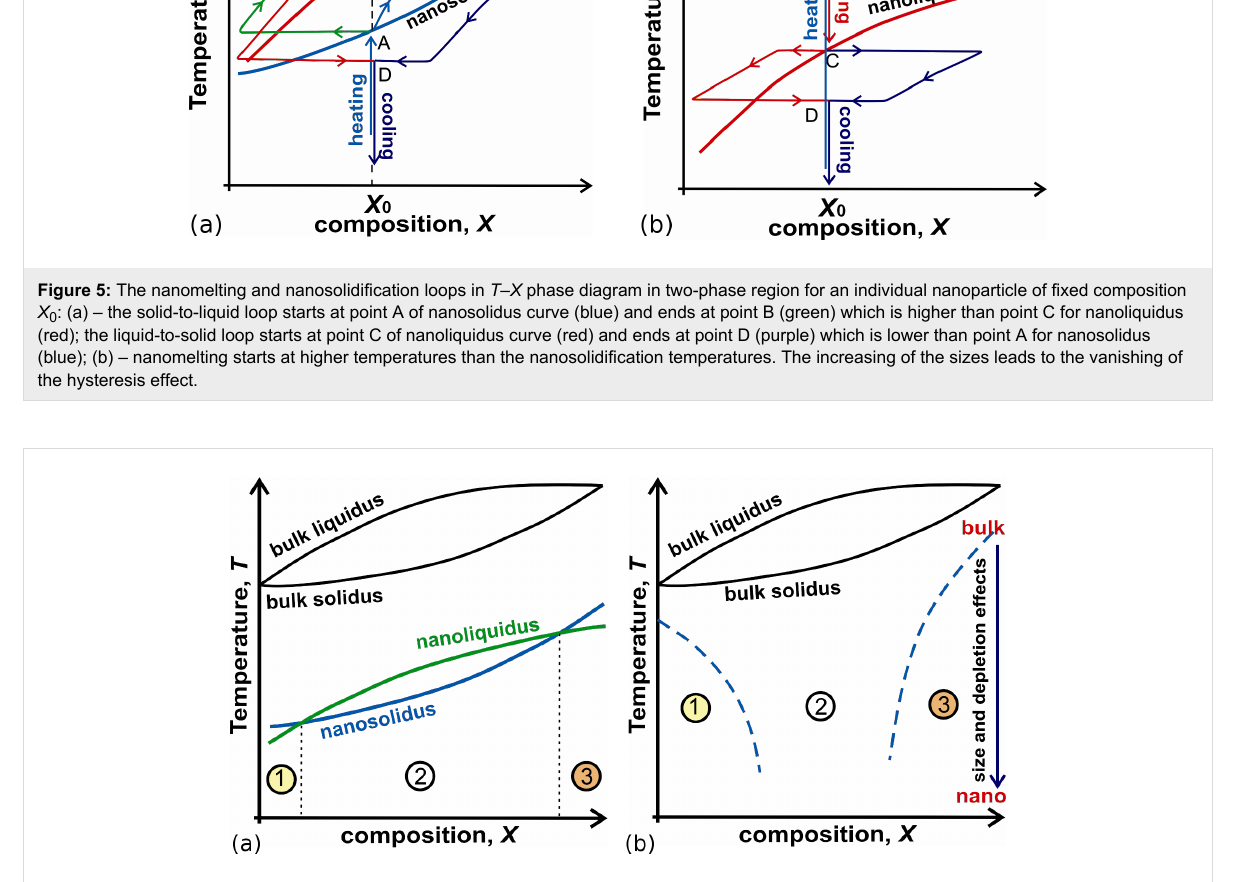
Figure 6: Qualitative representation of size-dependent solubility diagrams for solid–liquid transformation in the isolated Cu–Ni nanoparticle and phase transition symmetry breaking effect shown by the intersection of nanosolidus and nanoliquidus curves and regions (1) and (3) near small and large compositions: (a) – size-dependent shifting and changing of the shape of two-phase region (2) on solubility diagram; (b) – the effect of size on the narrowing of two-phase region (2). The increasing of the sizes leads to increase the width of two-phase region and the vanishing of asymmetry effect (Figure